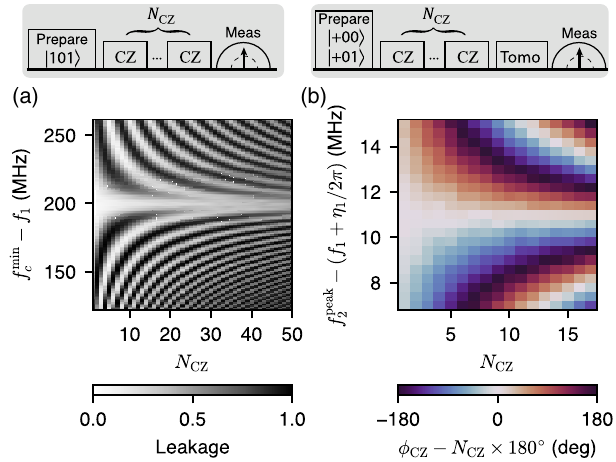
FIG. 30. Experimental data of fine-tuning measurements for the CZ gate. (a) Measuring the leakage of multiple CZ pulses to finely adjust the CPLR Z amplitude ( f min ). (b) Measuring the c − N CPHASE angle error ( ϕ × 180 °) of multiple CZ pulses CZ CZ to finely adjust the QB2 Z amplitude ( f peak 2 ).